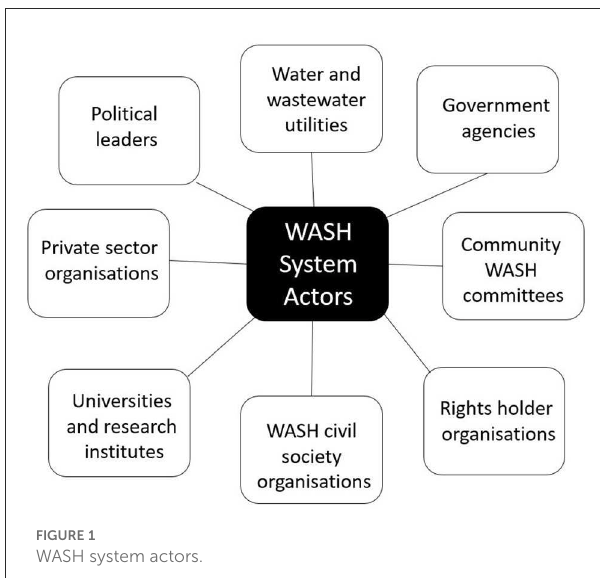
FIGURE1 WASH system